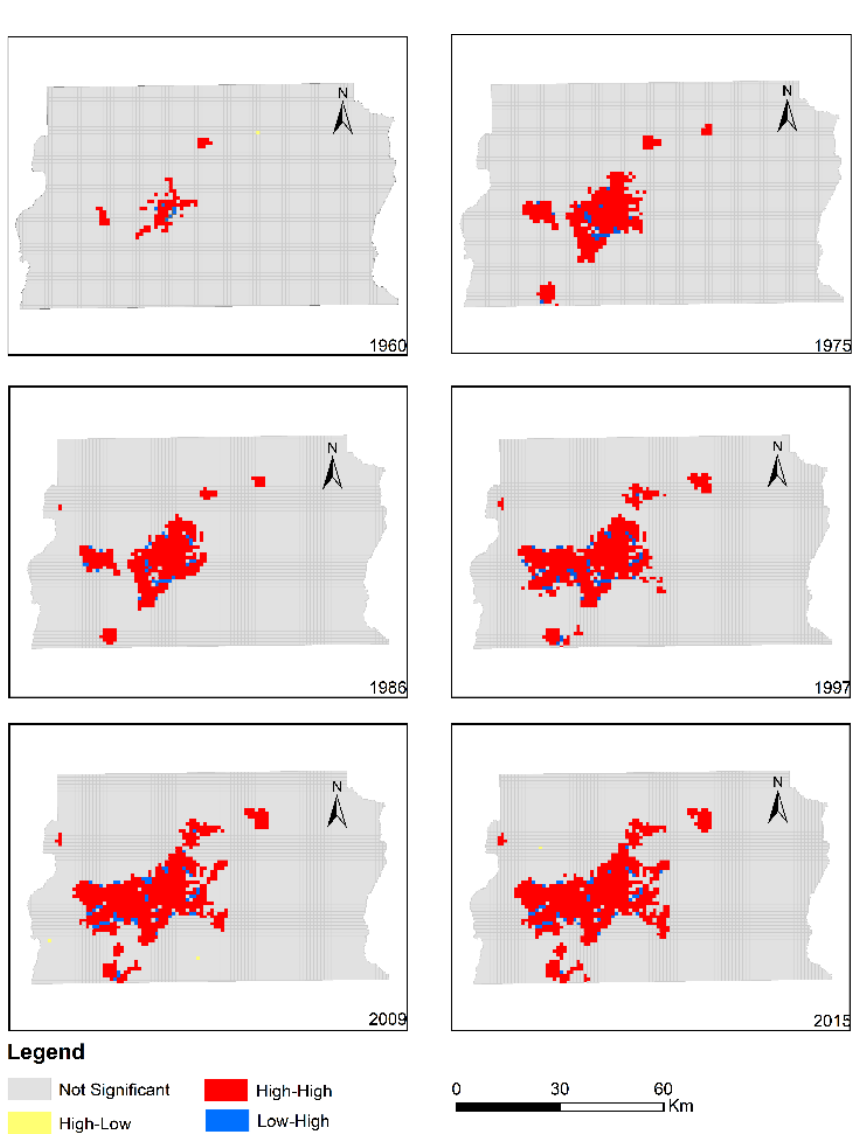
Figure 6. Spatio-temporal distribution of the local Moran’s I computed based on a 1 km × 1 km grid in the FDB.